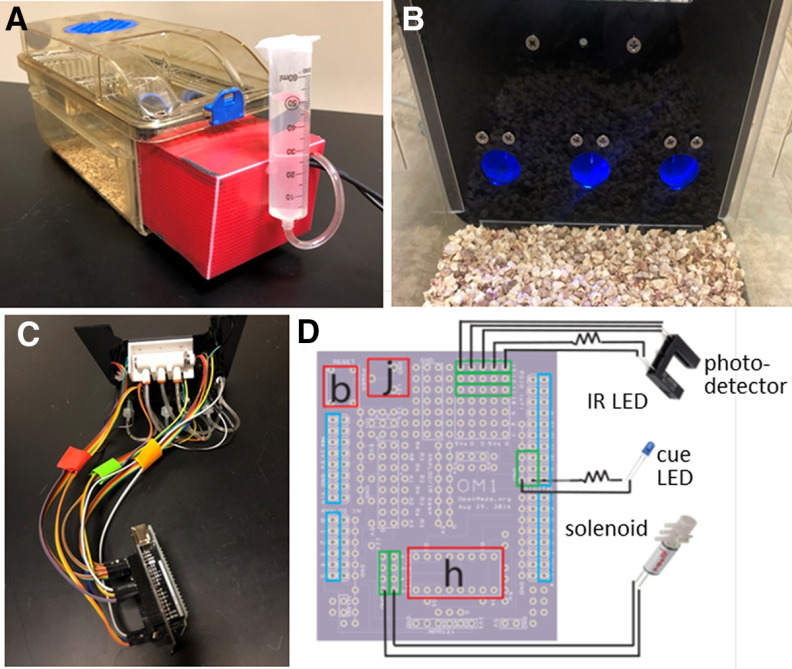
The DIY-NAMIC system is integrated into the homecage of standard mouse cages. A, The Arduino and all components of the DIY-NAMIC system are enclosed within the red encasing with the exception of a syringe for water or liquid reward, mounted on the outside. Modified cages remain compatible with most standard high-density ventilated racks. B, Inside homecage view of the DIY-NAMIC system including three noseports with blue LEDs illuminated, each of which contain a spout for liquid reward. C, The inside of the apparatus is shown including LEDs, solenoids, and IR head entry detectors wired to an Arduino UNO through an OpenMaze (OM1) shield. D, Schematic wiring diagram shows the wiring of one set of components (for one noseport of three total) to the OM1 shield. Blue rectangles indicate location of stacking headers for connection to Arduino. Red rectangles indicate locations of chip socket for H-bridge (h), push button for flush (b), and barrel jack (j). Green rectangles indicate location of female headers for connection to IR (LED and photodetector), cue LED, and solenoid components.